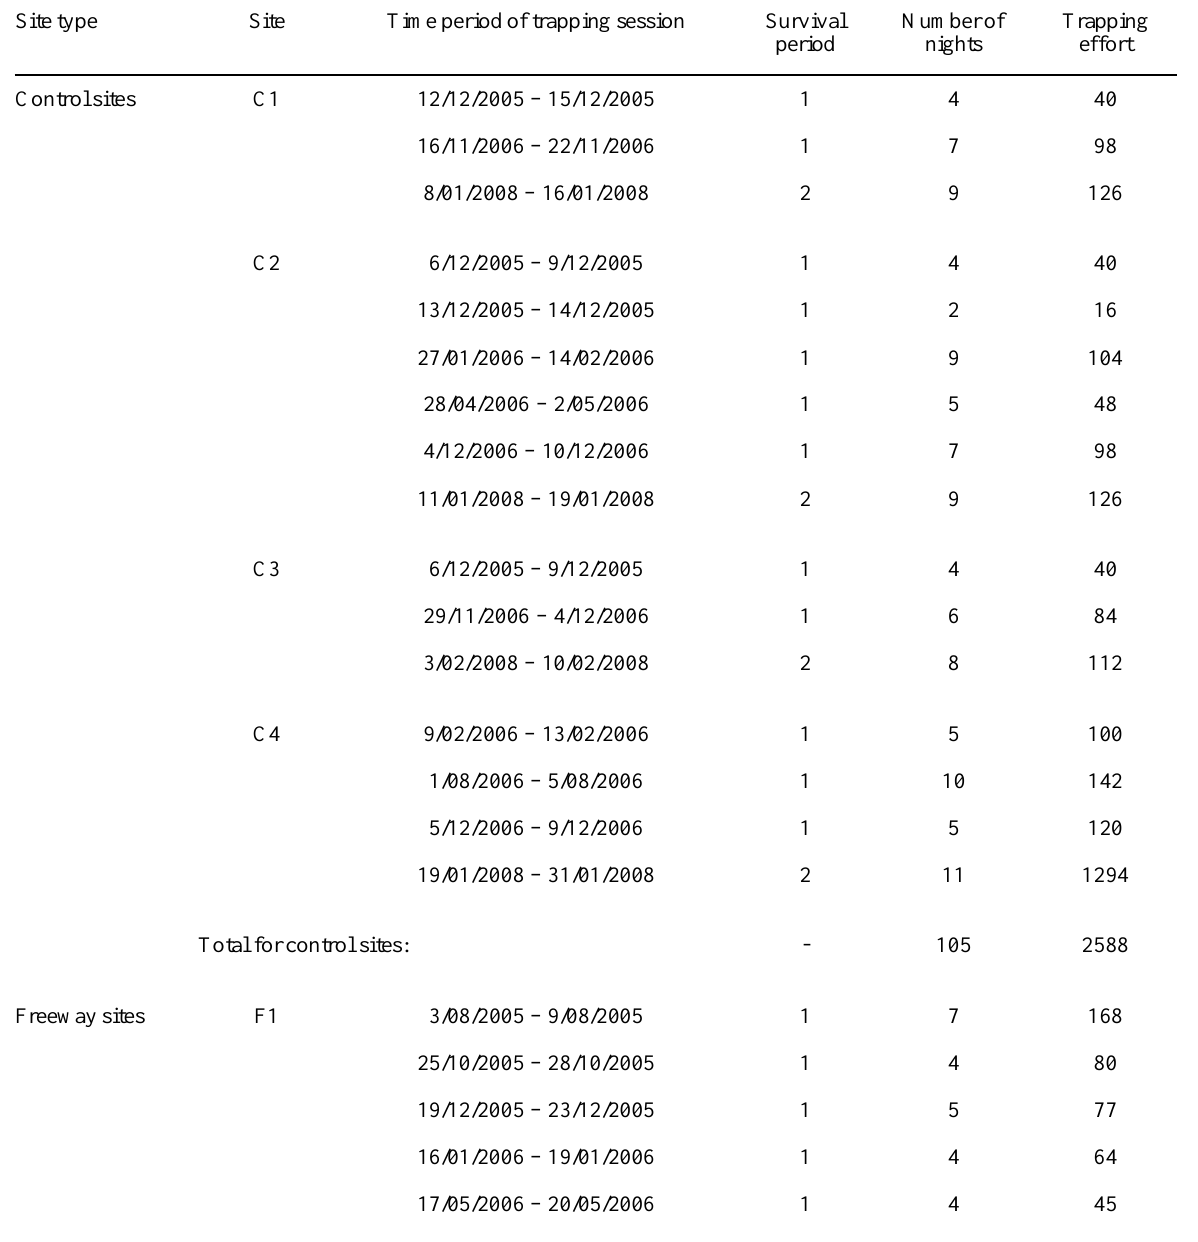
Table 1 . Trapping effort during census of squirrel glider ( Petaurus norfolcensis ) populations in southeast Australia. Trapping effort is the number of nights of trapping multiplied by the number of traps open, accounting for instances when a proportion of traps (in some cases, all traps) were closed on a given night. The first survival period includes trapping sessions between August 2005 and December 2006; the second includes trapping sessions between January 2007 and February